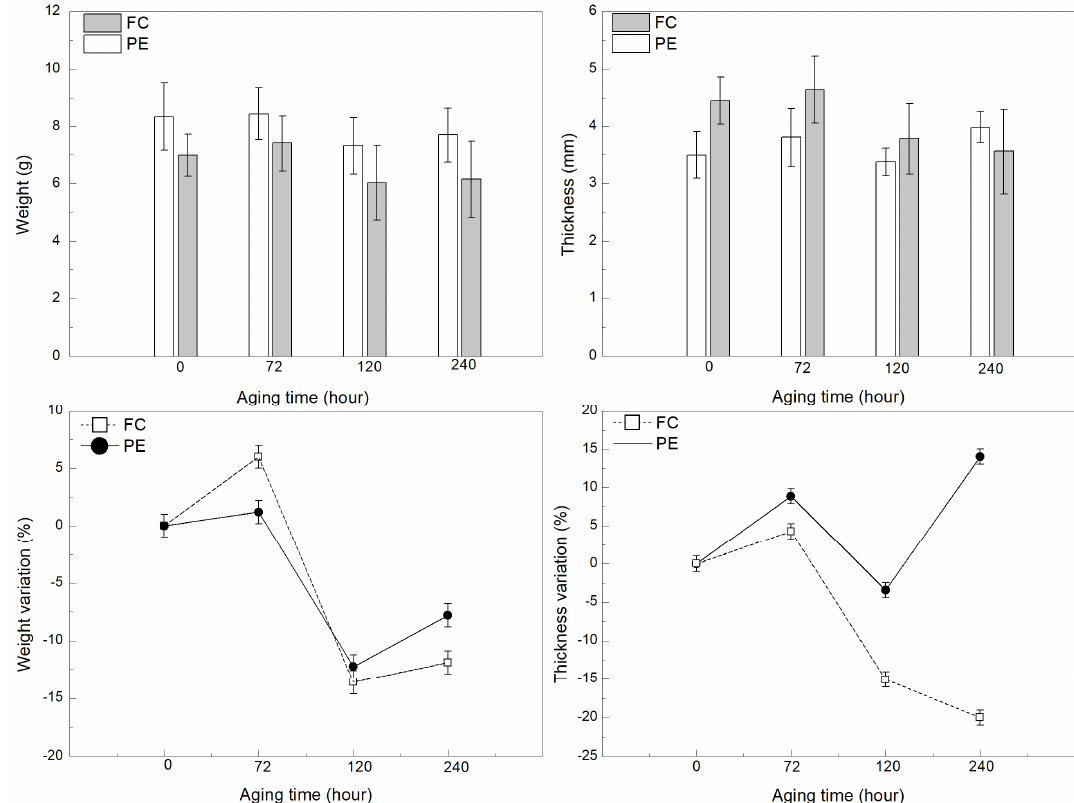
Figure 2. Mass and thickness losses of the plain epoxy (PE) and fique fabric reinforcing epoxy composite (FC) during thermal aging.